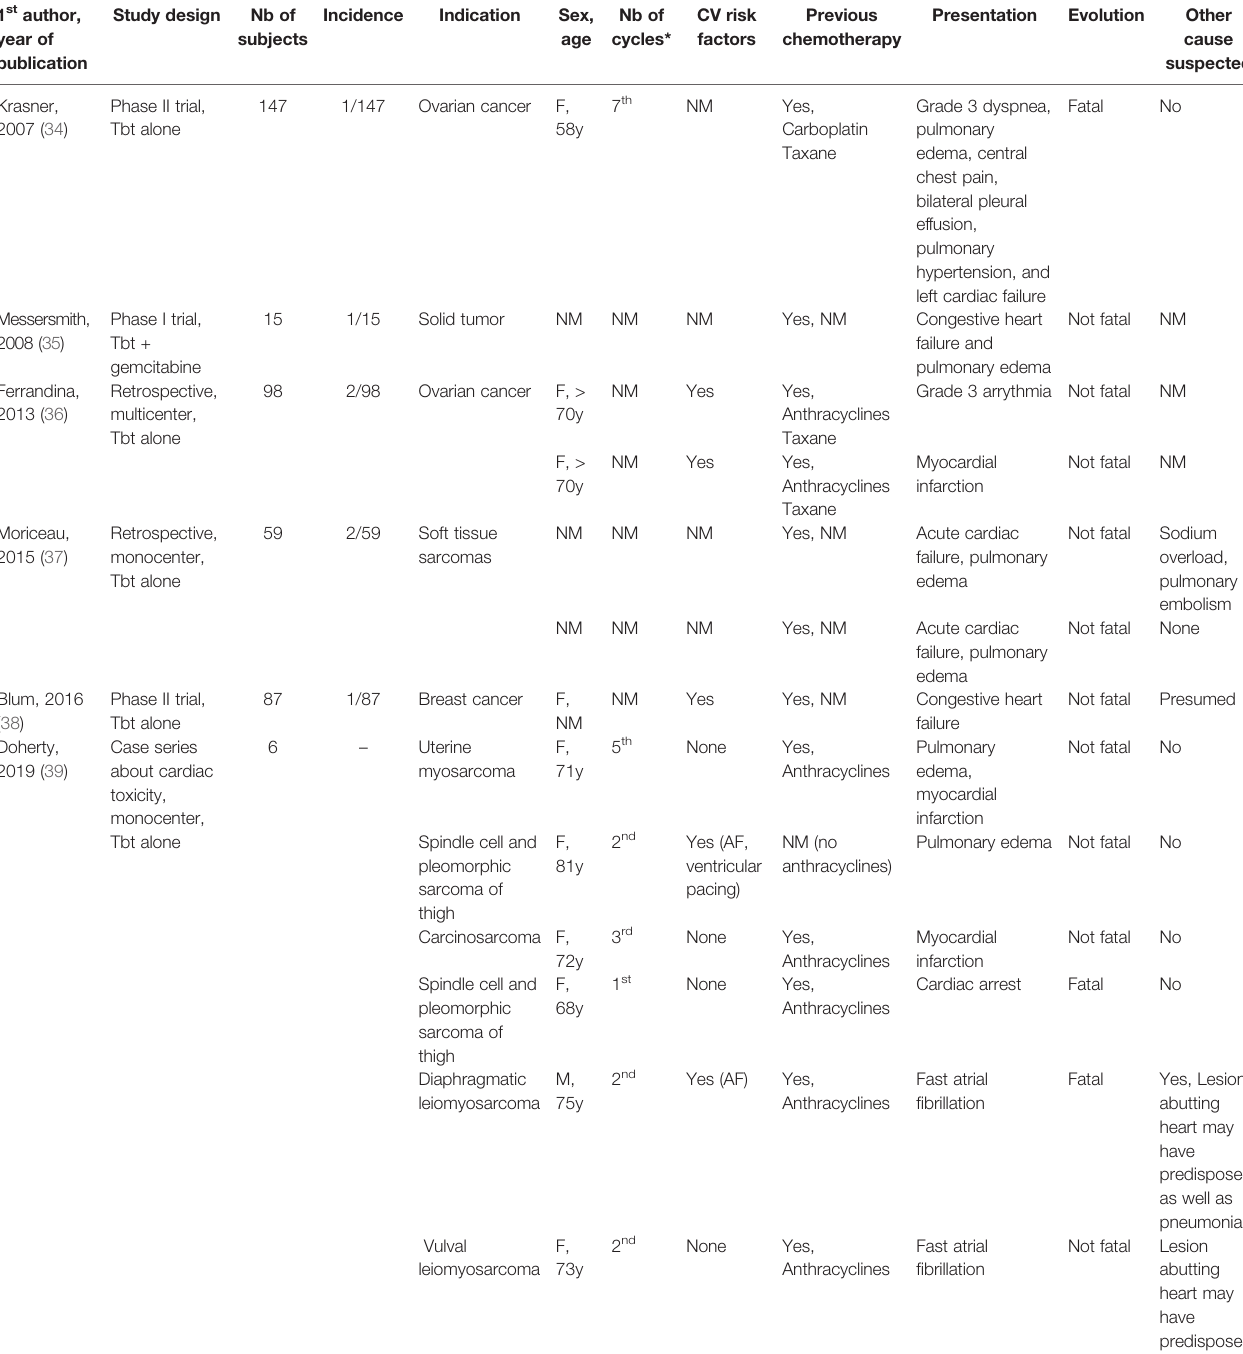
TABLE 2 | Detailed analysis of single cases of trabectedin-induced cardiotoxicity reported in clinical trials, case series and case